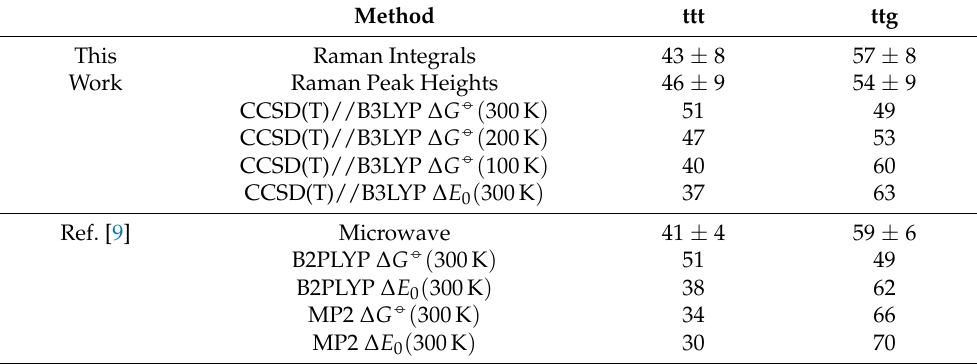
Table 5. Conformational ratio of methyl butanoate in supersonic expansions, determined by different methods. Theoretical populations calculated for relative Gibbs energies ( ∆ G −◦ ) or ZPE corrected electronic energies ( E 0 ) for the temperatures given in parentheses after full relaxation of the second torsional